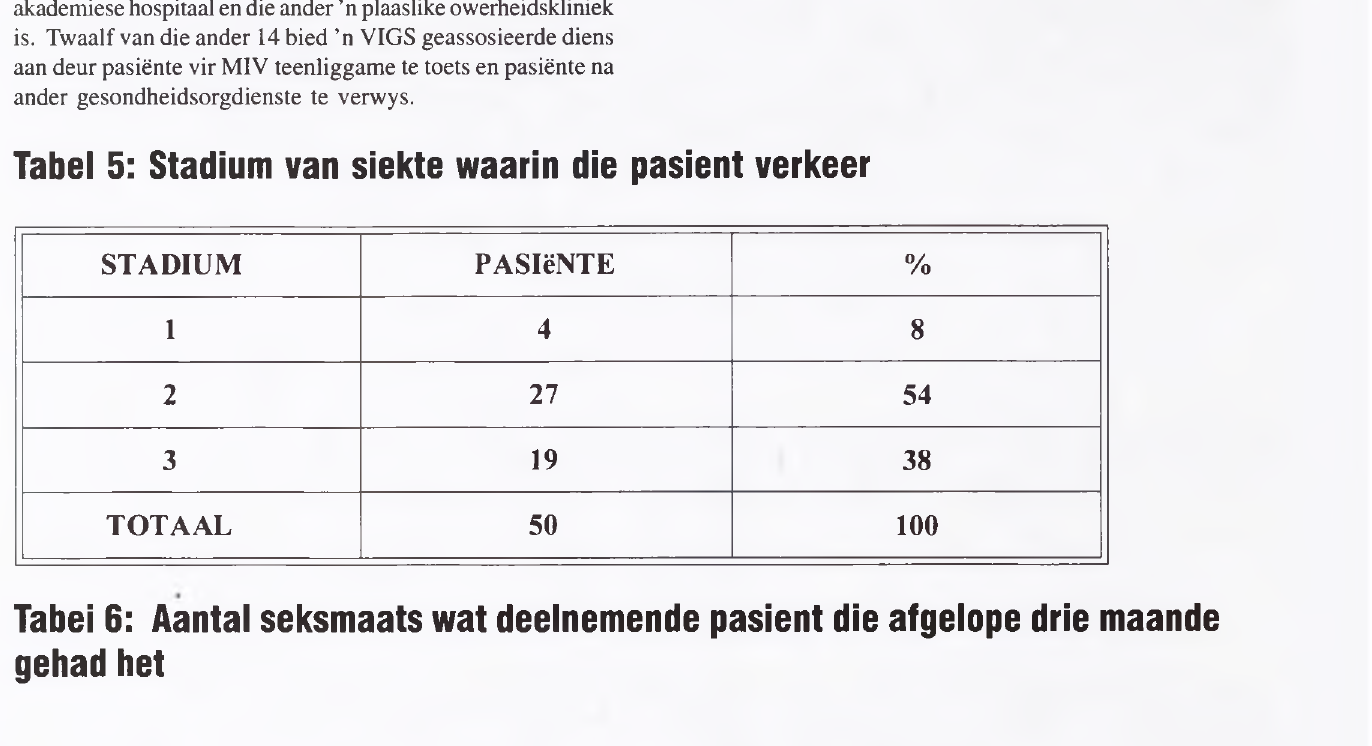
Tabel 7: Persone wat van die pasient se siekte bewus